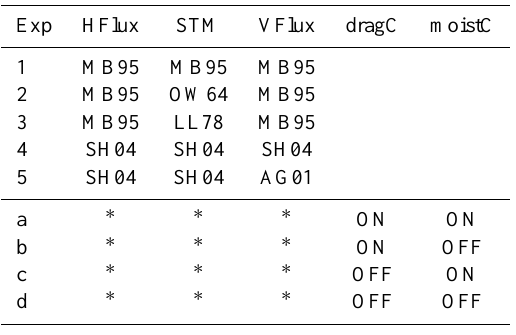
Table 2. Individual model set-ups (1–5) and the conducted exper- iments (a–d). The sand transport models (STM) used for the two principal horizontal flux (HFlux) models (MB95, SH04) and the selected vertical flux (VFlux) schemes with the number of the cor- responding set-up are given. The lower-case letters refer to the sen- sitivity experiments with the correction